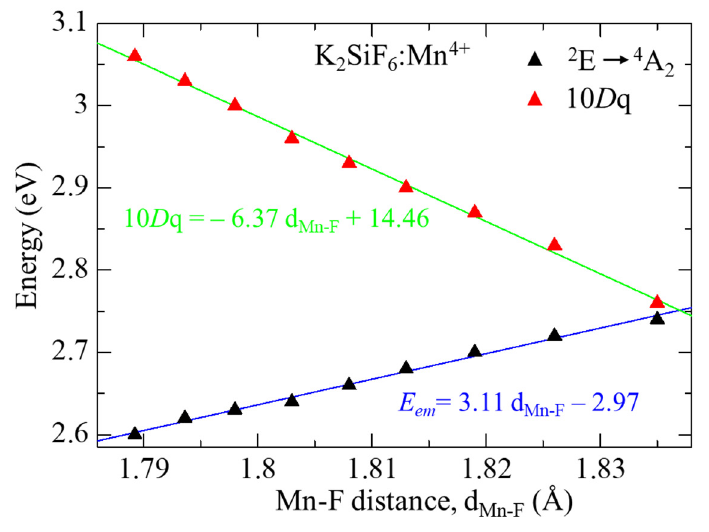
Figure 8. Calculated 10 Dq parameter and E em for K 2 SiF 6 :Mn 4+ as a function of Mn-F bond length.